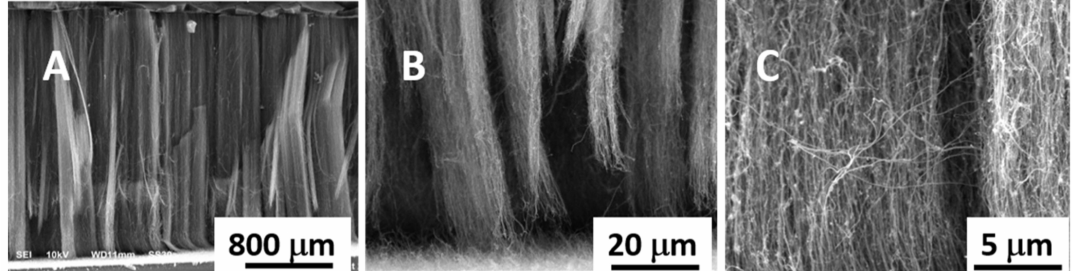
Figure 3. Cross-sectional view of SEM images of one-dimensional carbon nanotubes (CNTs) grown on a silicon wafer under CVD conditions for the nanocarbon coating on silicon flakes at 850 ◦ C. ( A ) Top-to-bottom cross-sectional view of the CNT forest; ( B ) CNT bundles near the substrate after having been wiped off by a razor blade; ( C ) Magnified view of ( B